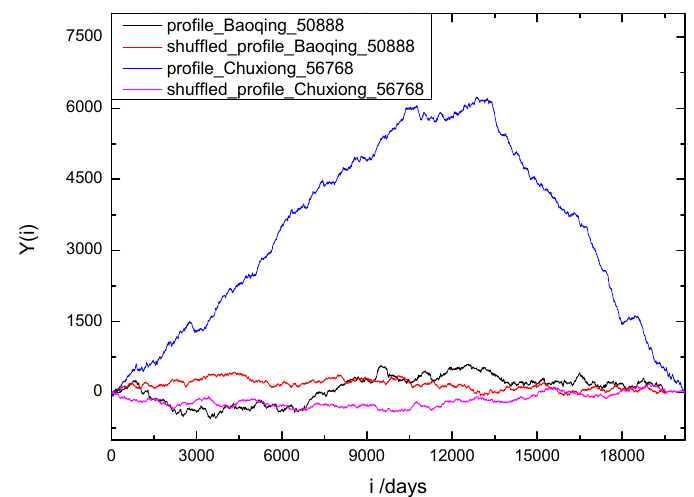
Figure 2. Profiles before and after shuffling two SSDA records during the time from 1954 to 2009 for stations Baoqing and Chuxiong.